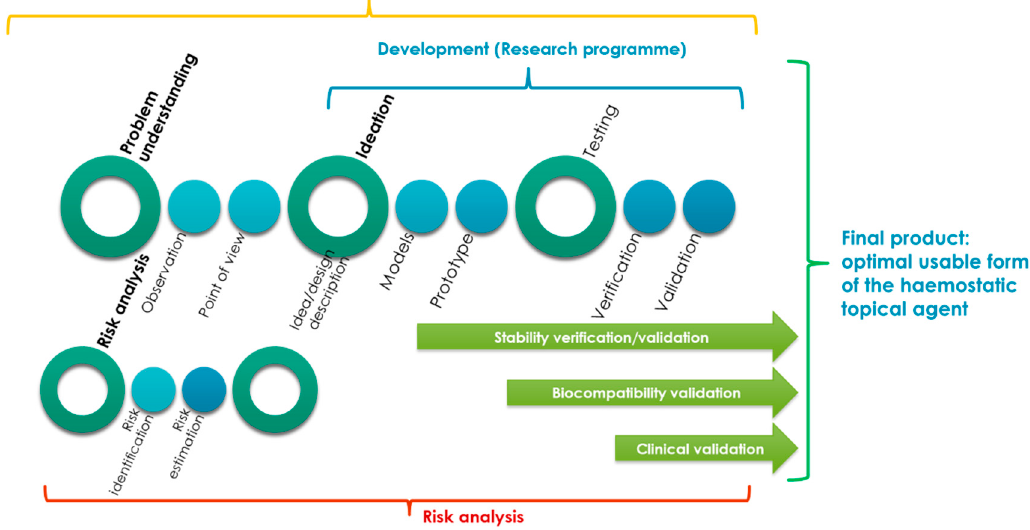
Figure 1. Proposal of the combination of design consideration and risk analysis processes for the development of the advanced medical devices—usable forms of topical haemostatic agents.